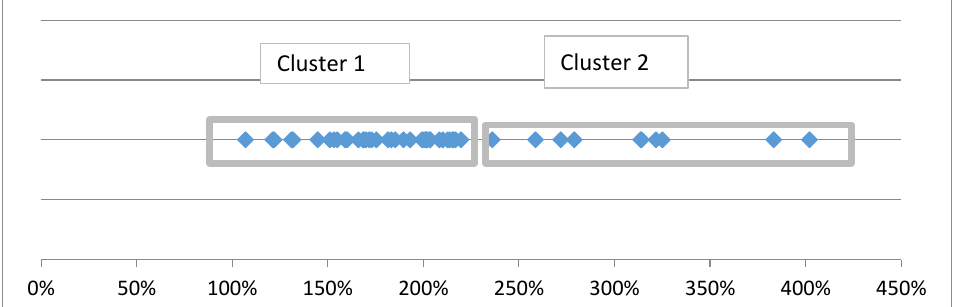
Figure A3. Percentage increase in estimated prices per kilometer of snow in 2016–2017 compared to prices actually paid.